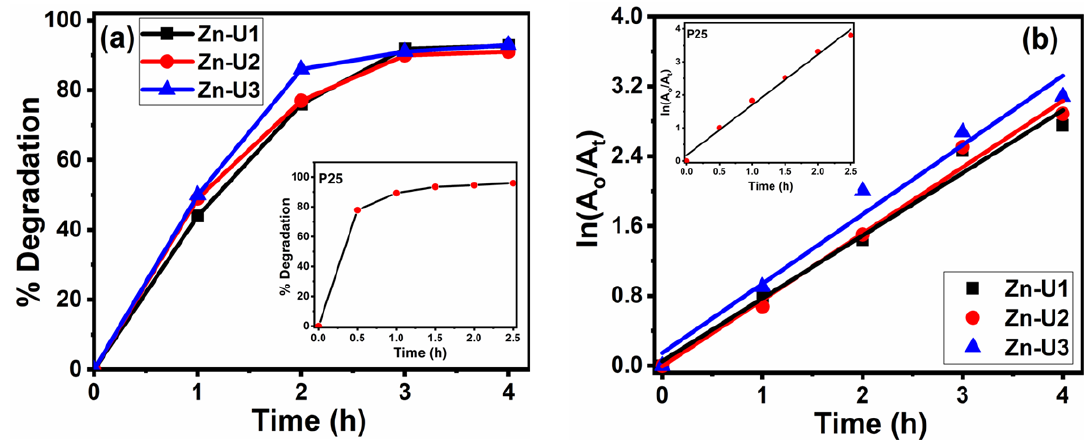
Figure 10. ( a ) RB dye degradation rate ( b ) the logarithmic change in concentration of RB as a function of irradiation time with insets of P25.